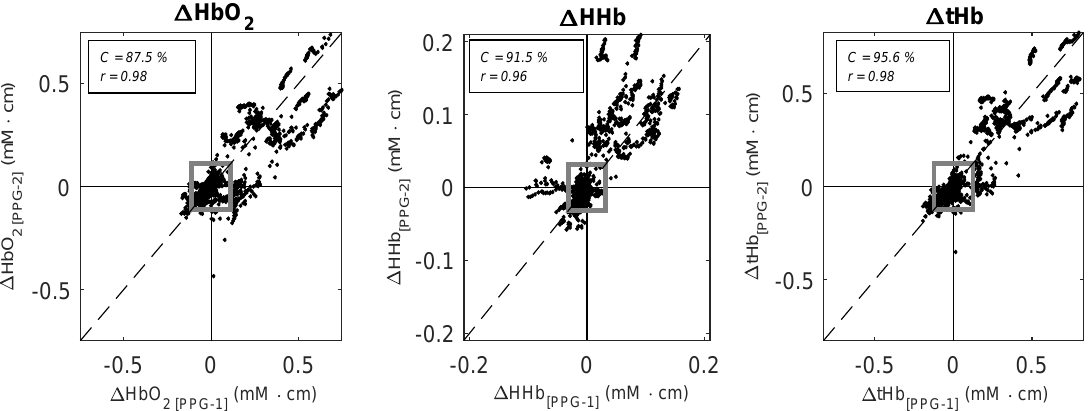
Figure 6. Four-quadrant plots analysis between ∆ HbO 2 , ∆ HHb, and ∆ tHb estimated by the PPG-2 (y-axis) and the PPG-1 sensor (x-axis) during the tilting protocol. Dotted lines represent the line of identity. A total number of = 100 pair points for each subject were used for the plots. The grey square indicates the 15% exclusion